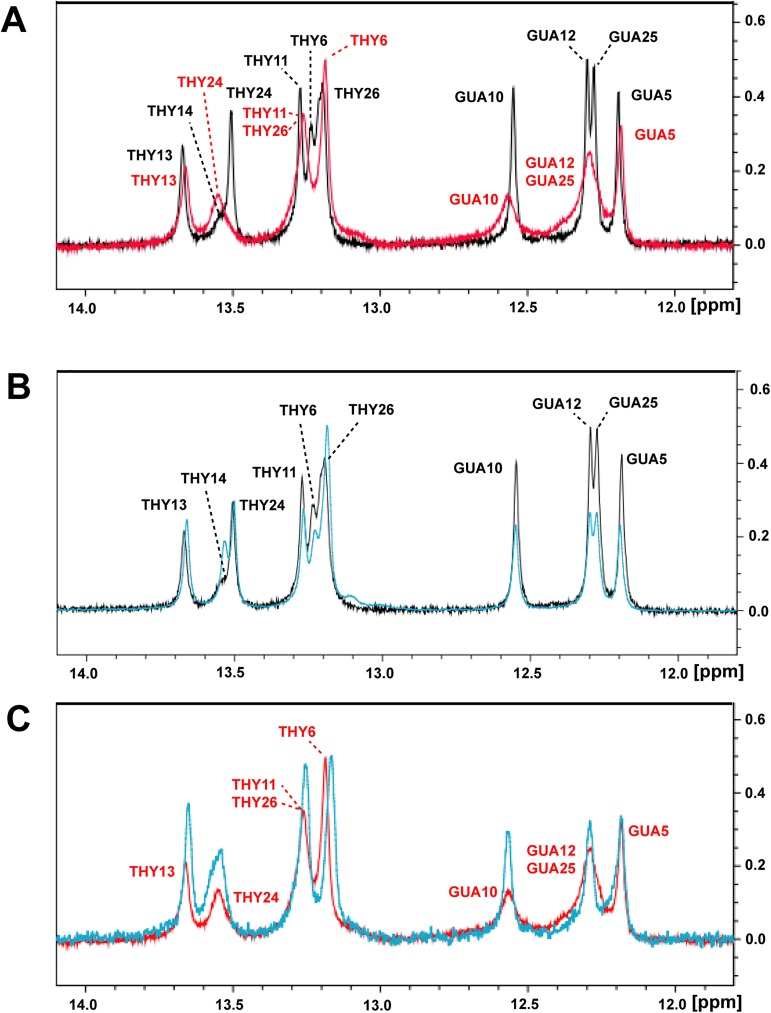
Comparisons of 1D DNA imino-proton NMR signals of the cognate DNA in the free and bound forms.(A) Superimposition of imino-proton spectra for the free cognate DNA (in black) and the cognate DNA bound to TZD (in red). Superimposition of imino-proton spectra for (B) the free cognate DNA (in black) and the cognate DNA bound to TZD23 (in cyan) and (C) the cognate DNA in complex with TZD12 (in cyan) and TZD (in red).